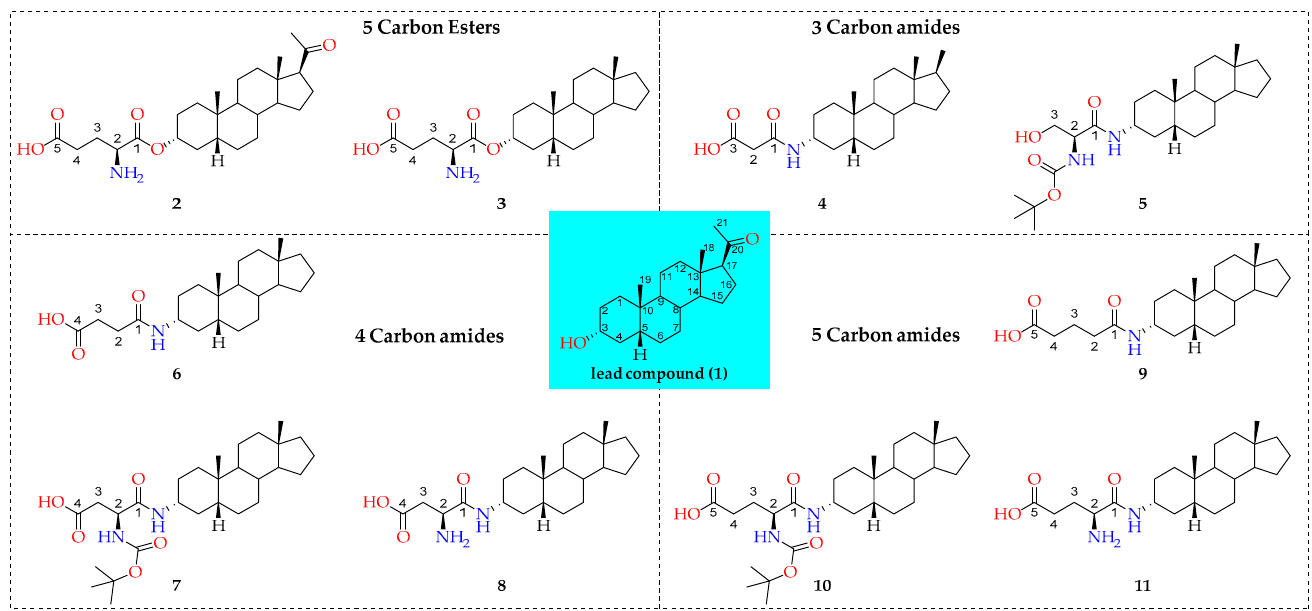
Figure 1. Structures of studied compounds.